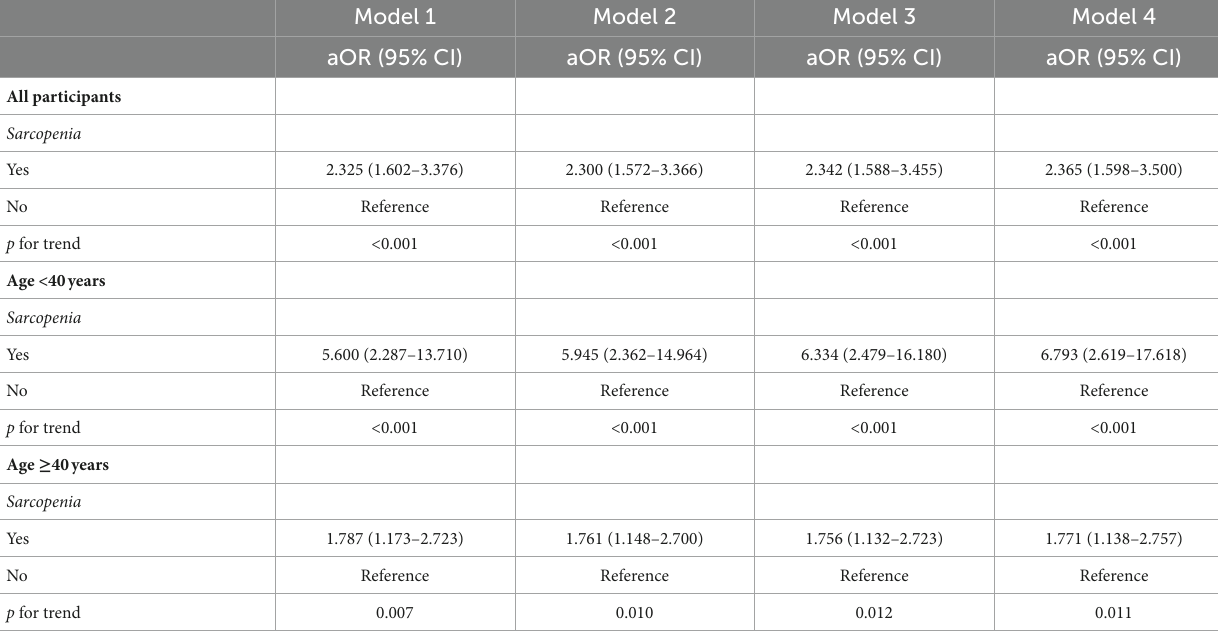
TABLE 3 Logistic regression analyzed the relationship between sarcopenia and the presence of kidney